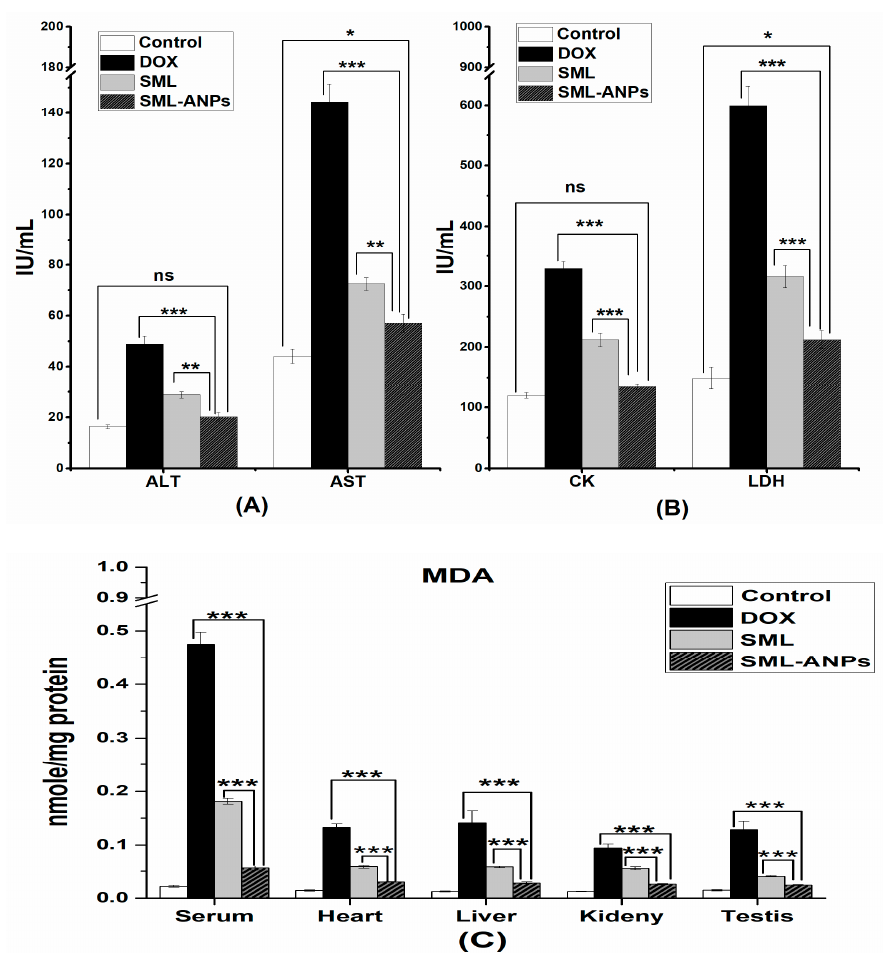
Figure 7. Cardiac ( A ), liver ( B ) and lipid peroxidation ( C ) biomarkers’ assessment. * p < 0.05, ** p < 0.001 and *** p < 0.0001 when compared to SML-ANPs group. Data are presented as means ± SE (n in each group = 8).